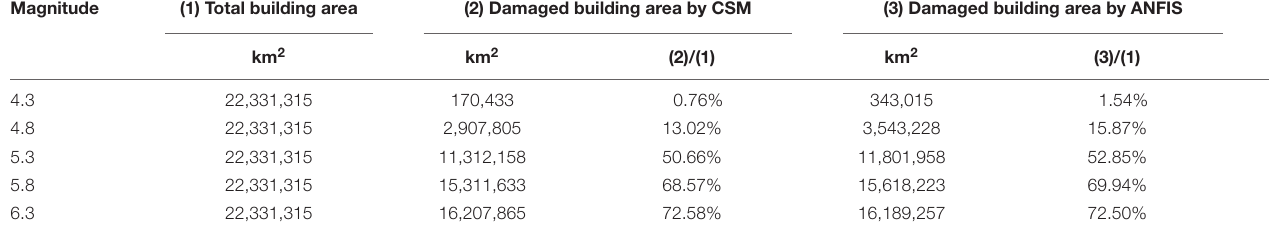
TABLE 2 | Estimation of damaged building area under five possible earthquakes by CSM and ANFIS.